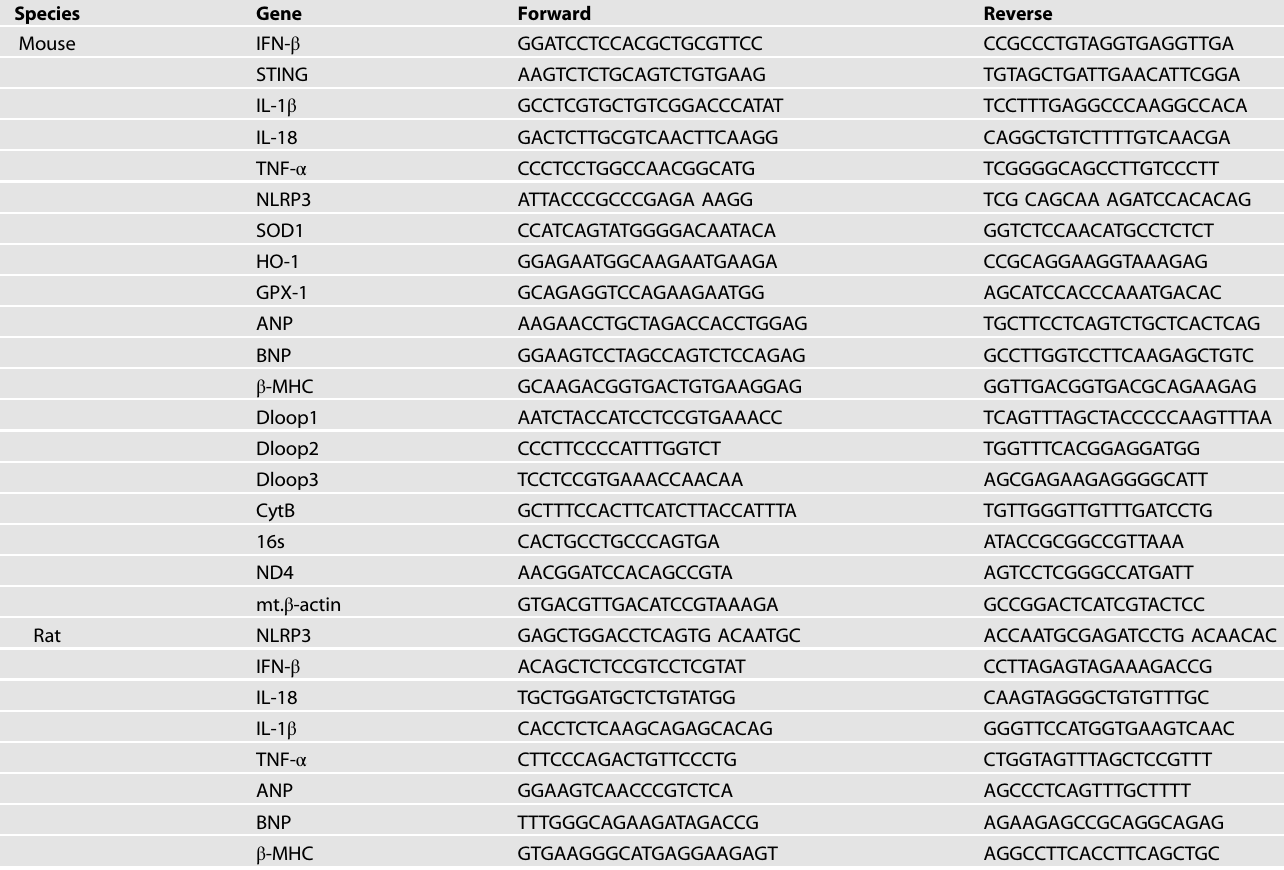
Table 2. Primer sequences for real-time RT-PCR.